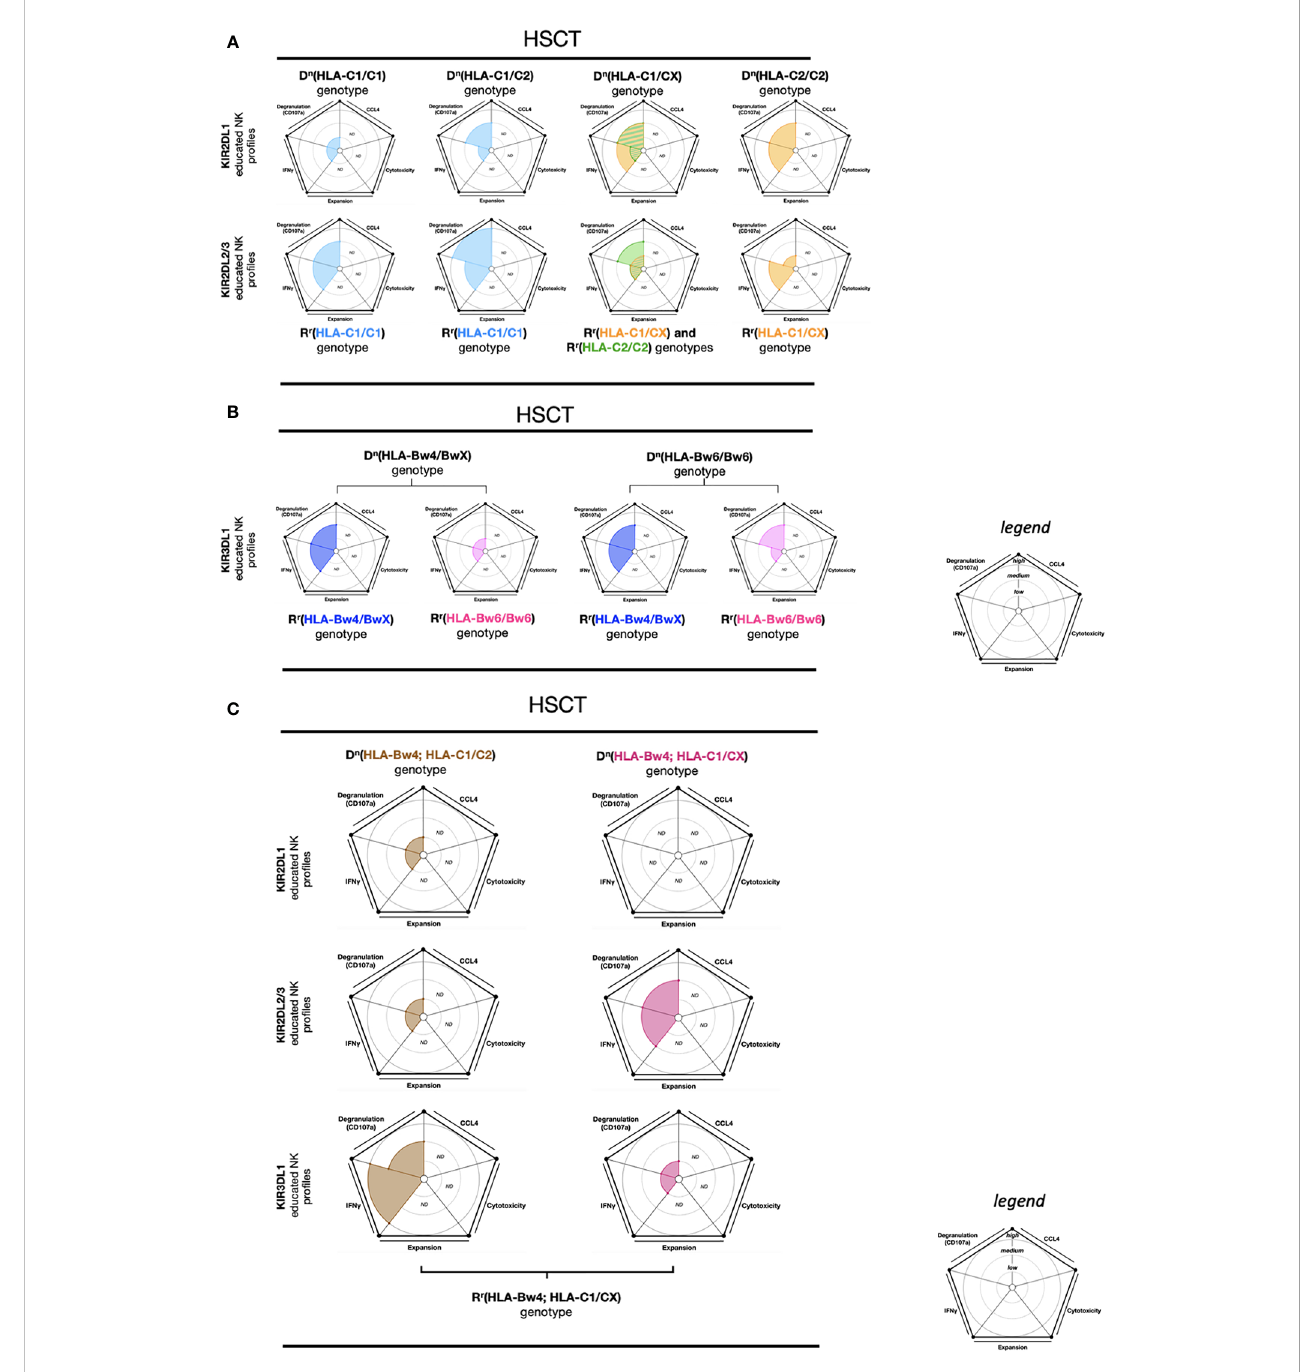
FIGURE 5 NK cell education pro fi les concerning to transplantation (HSCT). The different colors each represent a speci fi c-NKR educated NK pro fi le. Each educated NK pro fi les are de fi ned by fi ve factors (degranulation, CCL4, IFN g , cytotoxicity, and expansion). Each factor is described by the size of its slice on the pie chart according to three levels of reactivity (low, medium, and high). (A) KIR2DL1 and KIR2DL2/3 educated NK cells present fi ve educated NK pro fi les according to D n (HLA-C1/C1), D n (HLA-C1/C2), D n (HLA-C1/CX), and D n (HLA-C2/C2) genotypes as well as R r (genotype) associations. The NK educated reactivity represented in these charts was adapted via in vitro K562 cell stimulation (103). (B) KIR3DL1 educated NK cells present four educated NK pro fi les according to D n (HLA-Bw4/BwX) and D n (HLA-Bw6/Bw6) genotypes as well as R r (HLA-Bw4/BwX) or R r (HLA-Bw6/Bw6) associations. The NK educated reactivity represented in these charts was adapted via in vitro K562 cell stimulation (103). (C) KIR2DL1, KIR2DL2/3 and KIR3DL1 educated NK cells present six educated NK pro fi les according to D n (HLA-Bw4; HLA-C1/C2) and D n (HLA-Bw4; HLA-C1/CX) genotypes, associated with R r (HLA-Bw4; HLA-C1/CX). The NK educated reactivity represented in these charts was adapted via in vitro K562 cell stimulation (103). ND, no data is described. The ribbed area describes a superposition of two areas relative to the colors exhibited. The donor genotypes are denoted as D n and receiver genotypes are denoted as R r